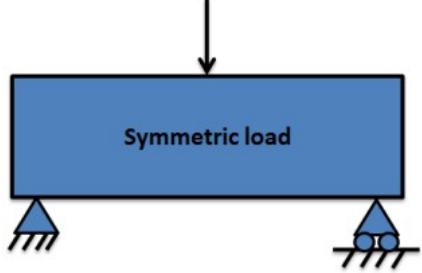
Figure 5 . Schematics of three‐point bending of a simply supported concrete beam.